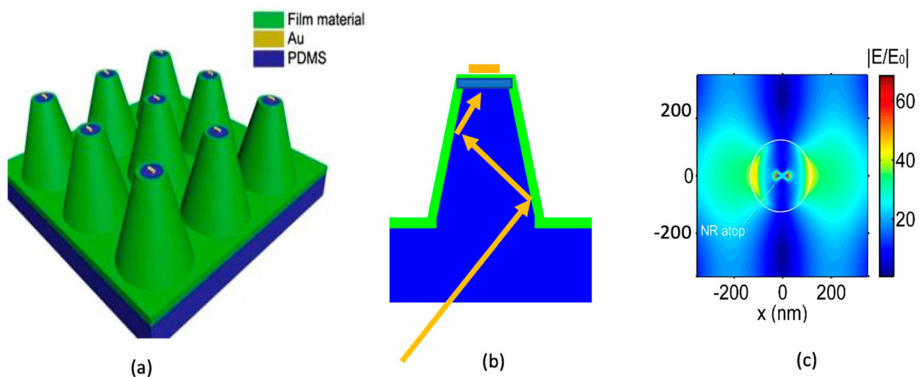
Figure 1. The illustration of nanocone structure designed; ( a ) gold nanorod(s) are located at the top of the transparent PDMS (Polydimethylsiloxane) cones coated with thin Si, ( b ) Internal reflection of incident light from the bottom reaches nanorods, ( c ) Simulations shows electric field enhancement at the tips of the nanorod (one nanorod case).